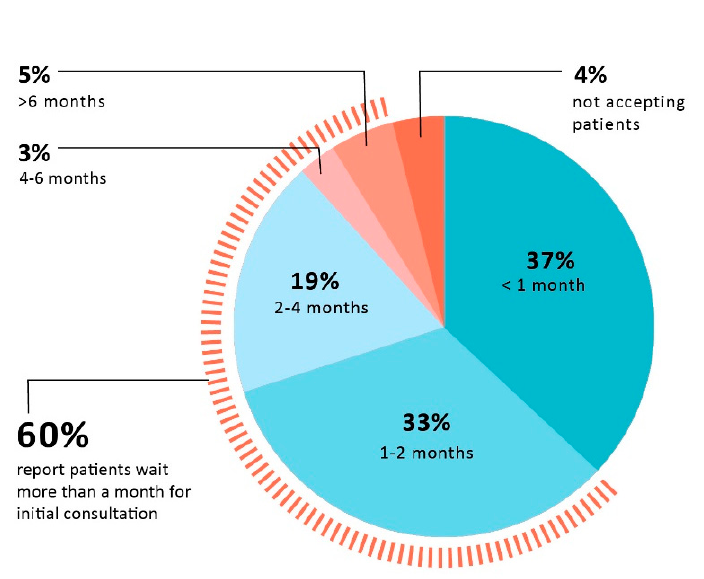
Figure 2. Wait times for initial consultation.